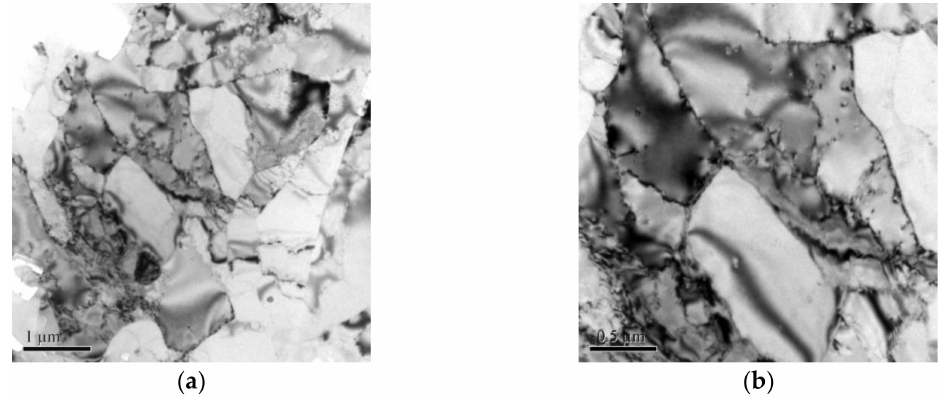
Figure 3. TEM images of alloy N1 at 50% cold rolling reduction. ( a ) with 2550 times magnification and ( b ) with 5000 times magnification.